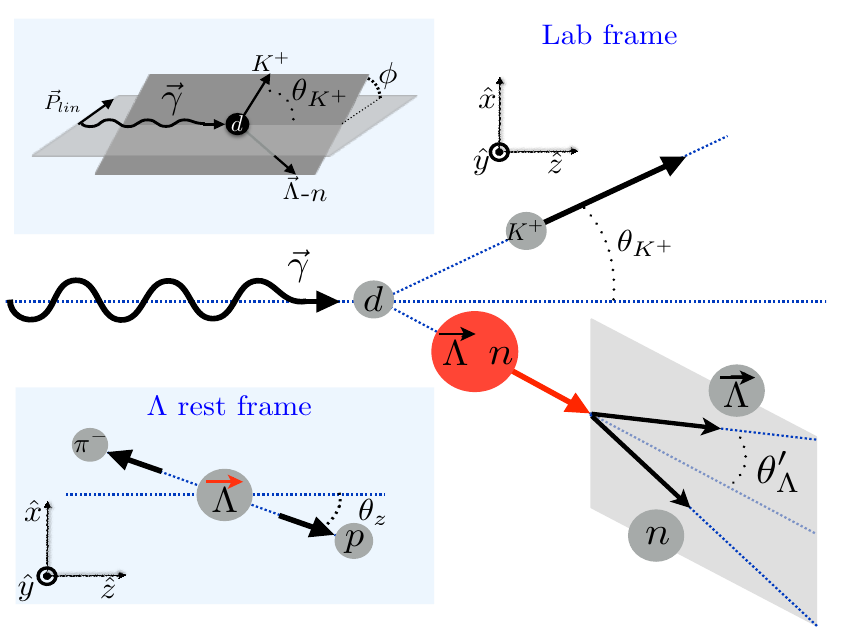
Figure 3: Reaction plane definition for γ d → K + Λ n . The upper left panel shows Figure 3. Reaction plane definition for  d ! K + ⇤ n . The upper left panel shows the definition of the Figure 2. Top panel: Missing-mass distribution of the kaon azimuthal angle  in which ⌃ produces reaction  d , and the hyperon angle θ Λ (cid:48) , which figure defines the kaon laboratory polar angle θ K + is with respect to an axis pointing along the momentum of the YN a modulation (see Eq. [1]). The lower left panel shows the definition of ✓ (and correspondingly ✓ ) z x in which the double-polarization observables pro- duce modulations. The main figure defines the kaon laboratory polar angle ✓ , and the hyperon K + angle ✓ , which is in respect to an axis pointing 0 ⇤ along the momentum of the Y N pair.